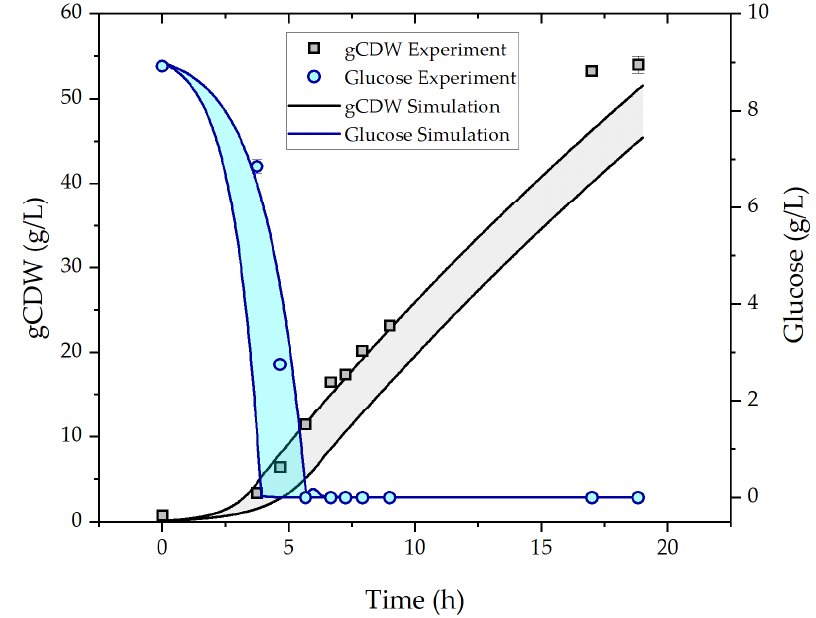
Figure 4. Experimental and simulation results of dry cell weight and glucose concentration of the E. coli fed-batch